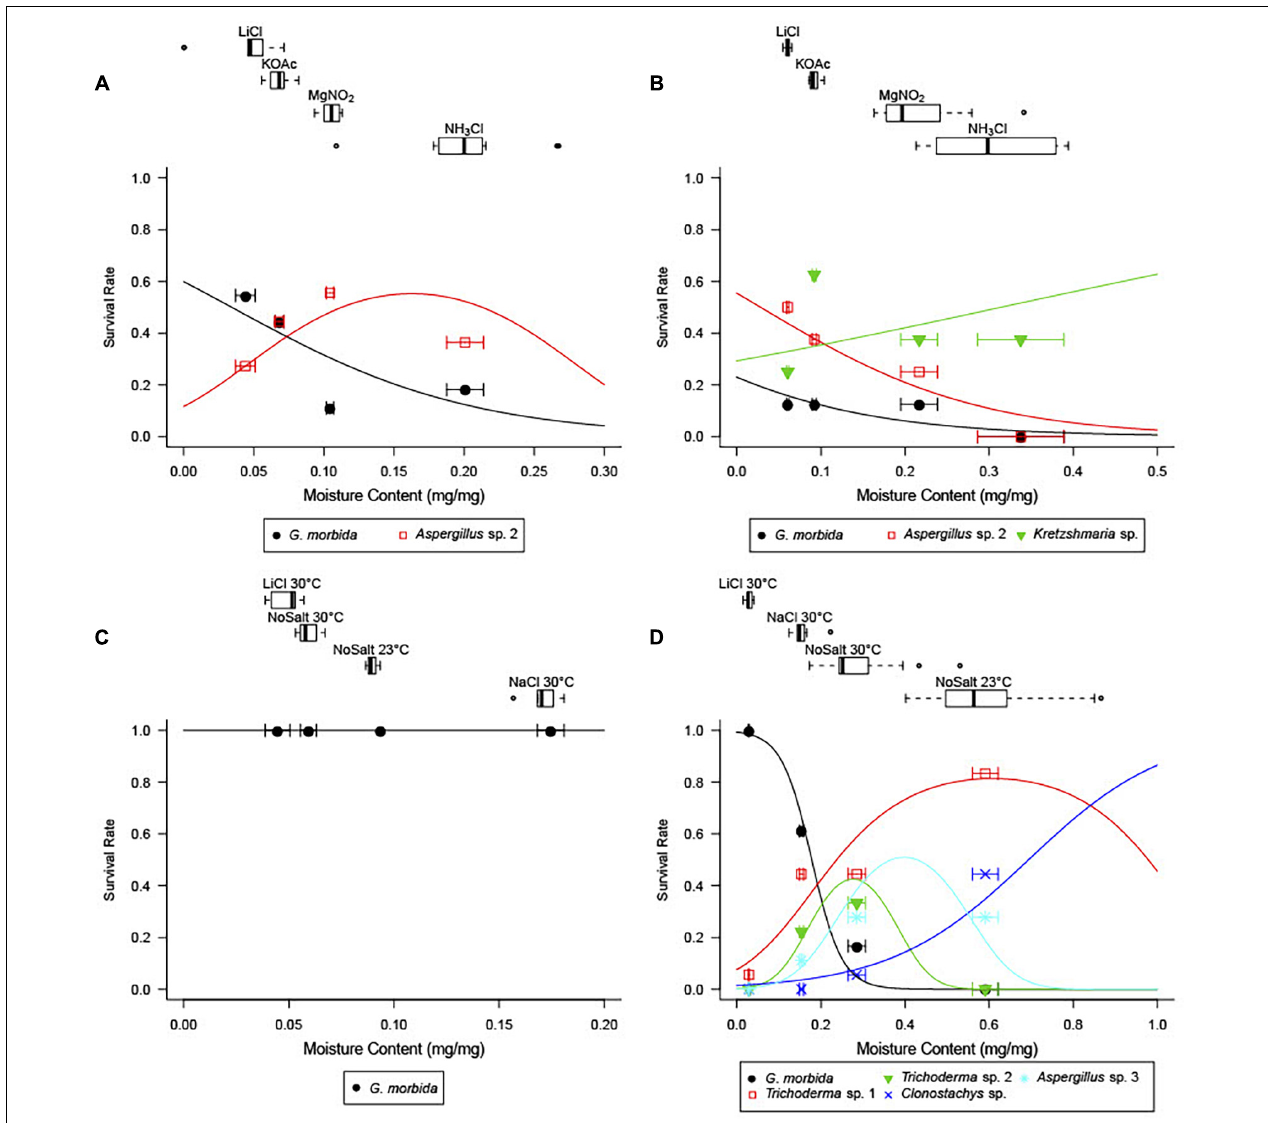
FIGURE 2 | Wood moisture content (MC) by treatment (top panels) and observed and predicted survival of fungal species as a function of wood MC from best-fit logistic regressions (bottom panels) in Experiments 1 (A) , 2 (B) , 3 (C) , and 4 (D) . For each saturated salt solution treatment, boxes-and-whiskers show percentiles of final wood MC, and points and error bars in the plotting area give observed mean survival ± SE final